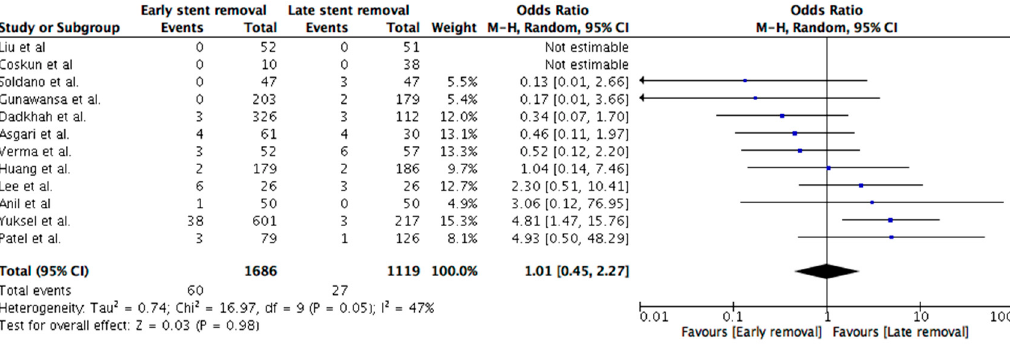
Figure A3. Forest plot of major urological complications for early (<3 weeks) versus late (>3 weeks) stent removal.